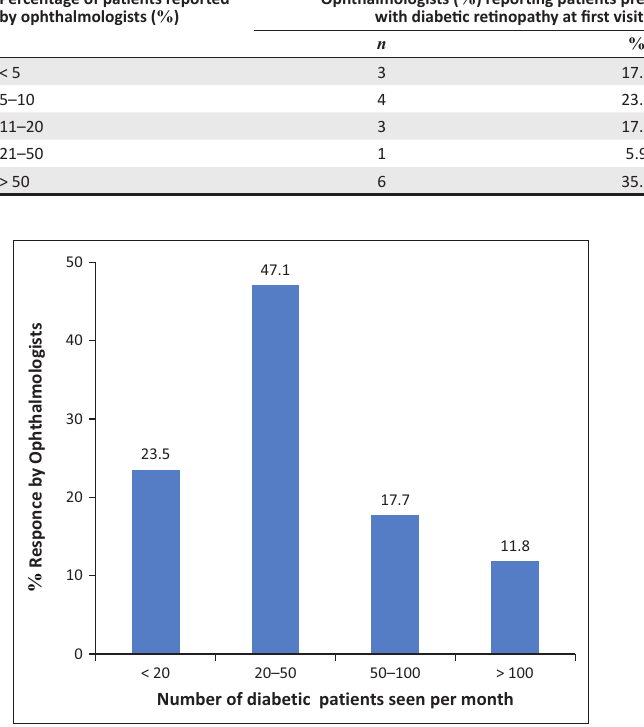
FIGURE 6: Number of patients seen per month by